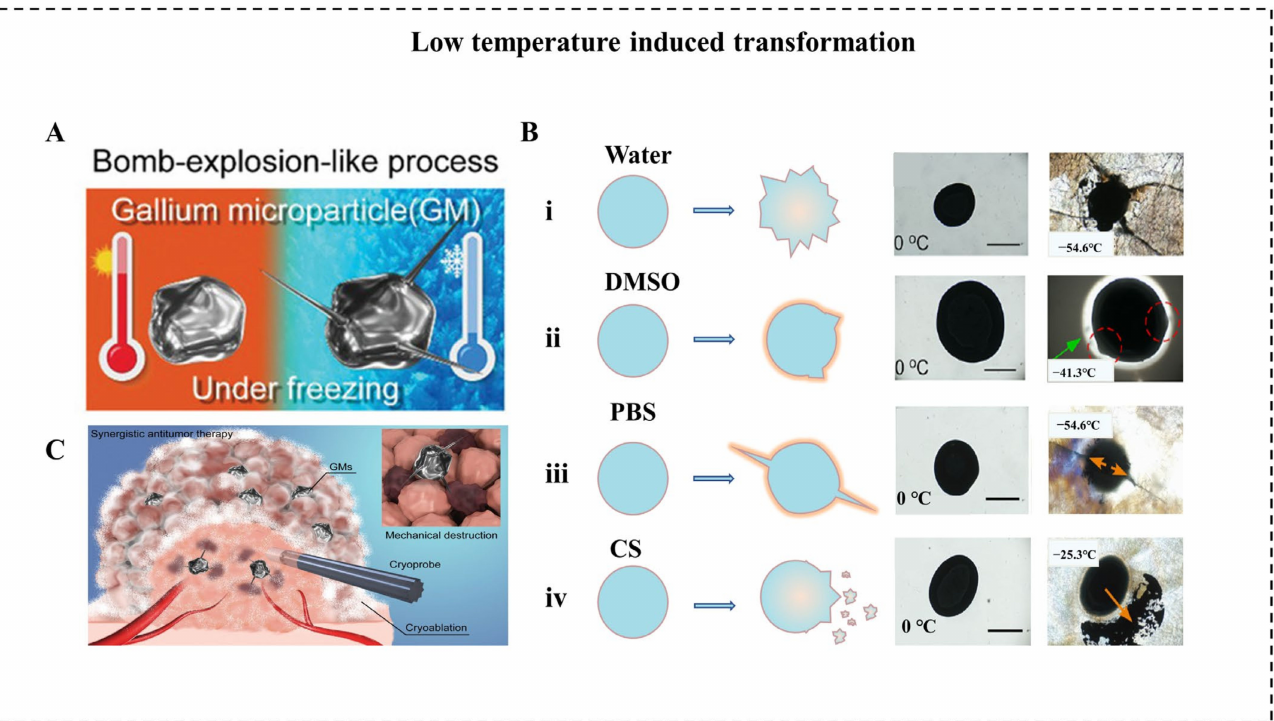
Figure 6. Low-temperature-induced morphological transformation. ( A ) Schematic illustration of low temperature-induced LM bomb-explosion-like transformation [18]. ( B ) Schematic illustration of synergistic antitumor therapy based on cryoabla- tion as well as LM-induced mechanical disruption of tumors [18]. ( C ) Schematic illustration and representative photographs of LM in ( i ) water, ( ii ) DMSO solution, ( iii ) PBS solution, and ( iv ) chitosan (CS) solution